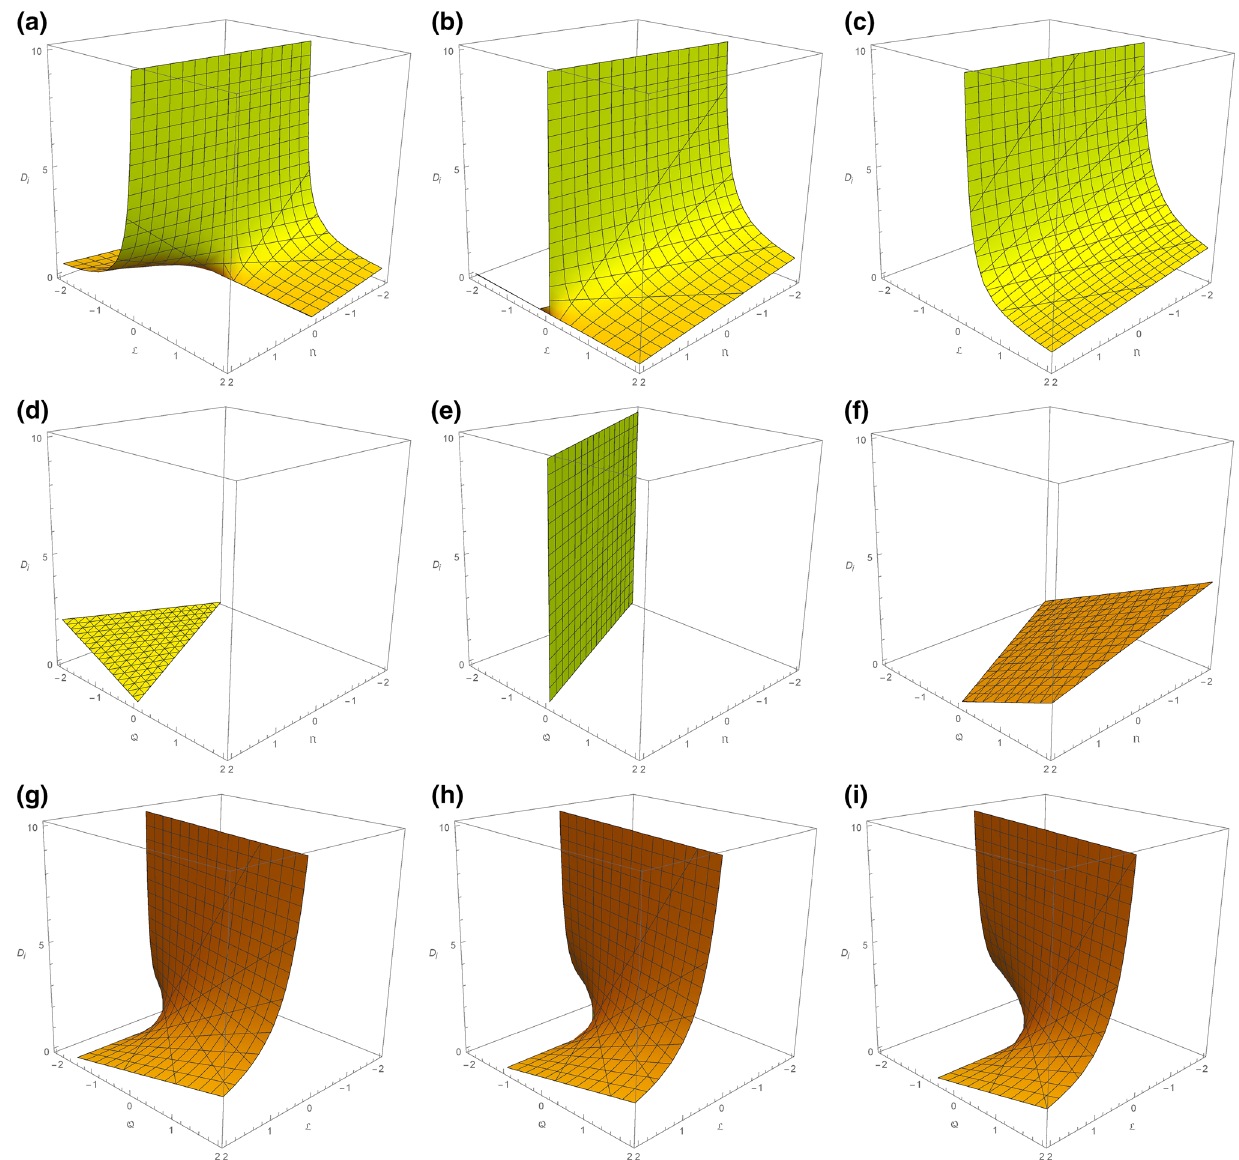
Fig. 9 The variation of D i versus typical values of the L , Q and N parameters in (48) for the radiation background. We have set M = 1 without loss of generality in all the plots. The plots a – c represent the